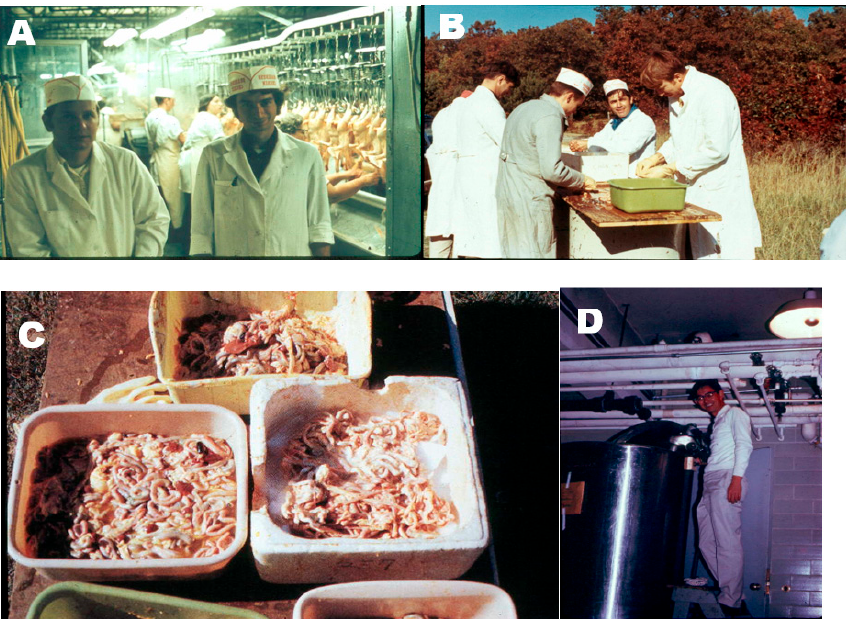
Figure 9. ( A ). The first attempt. Dr. Robert Cousins on the left and me collecting intestines from the trough behind us at the BrakeBush facility. ( B ). The second collection of intestines with several members of the DeLuca laboratory helping out. From left to right is Dr. Ian Boyle, Dr. Chuck Frolich, Dr. Jack Omdahl and Dr. Hector DeLuca. ( C ). Cleaned and processed intestines placed on dry ice. ( D ). Dr. Tatsuo Suda inspecting the huge stainless steel fermentation tank that contained approximately 400 pounds of mashed intestines and several hundred gallons of chloroform and methanol for the lipid extraction. Holick copyright 2023. Reproduced with permission.